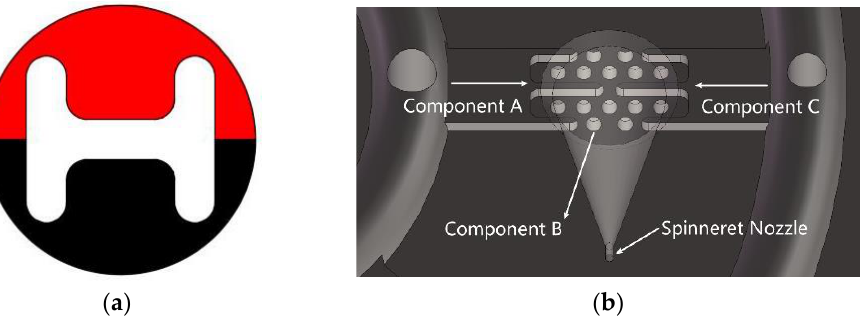
Figure 9. Design drawing of the cross-section of the “fishbone” fiber. ( a ) The red domain is component A, white domain is component B, and black domain is component C. ( b ) The flow of polymers in the spinning pack.